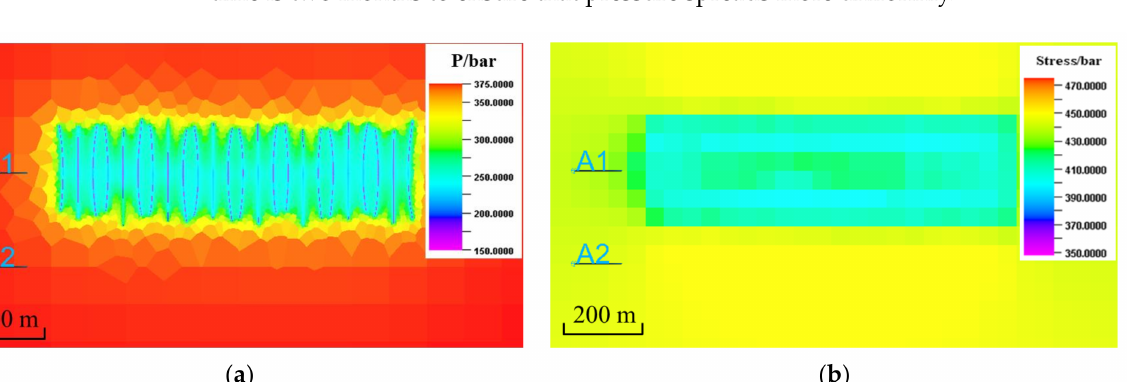
after injecting water and the initial undeveloped